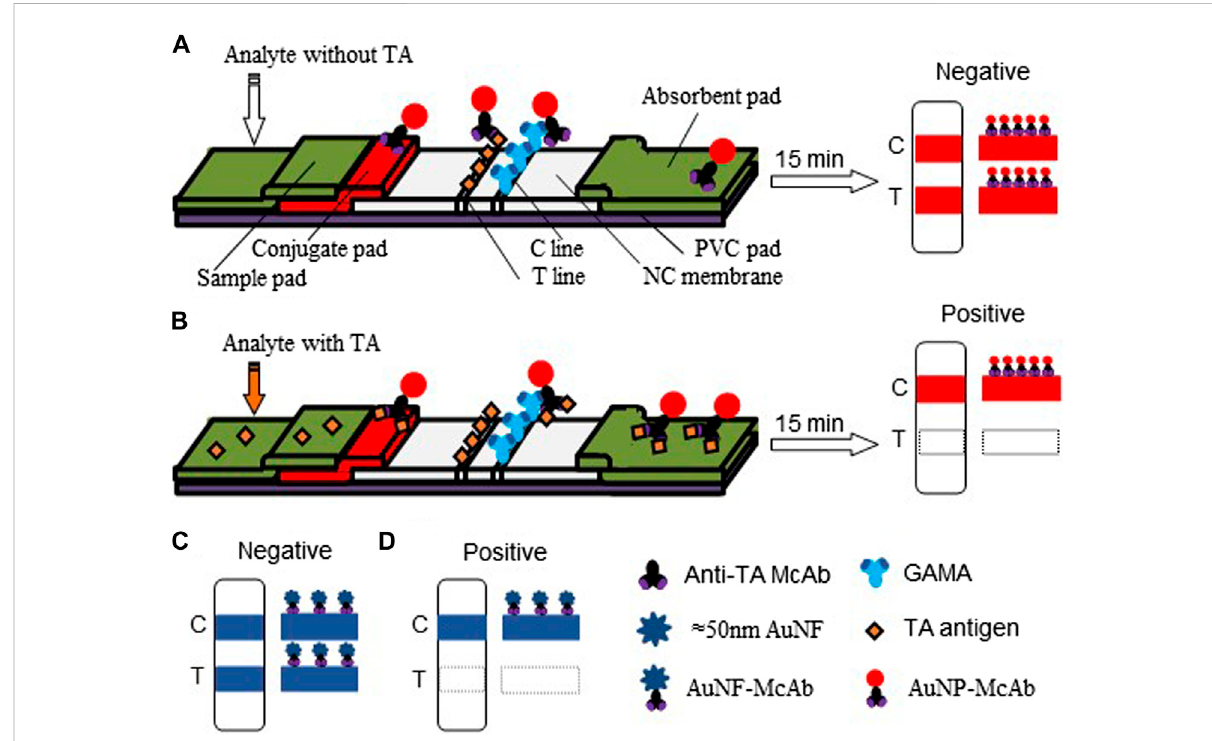
FIGURE 2 SchematicdiagramoftheAuNP-based andAuNF-basedstriptests. (A) TheconventionalAuNPassayandthediagramofnegativeresult. (B) The competition mechanism of AuNP assay and the positive result. (C) The construct of AuNF test strip and the negative result. (D) The competition mechanism under signal enhancing and the positive